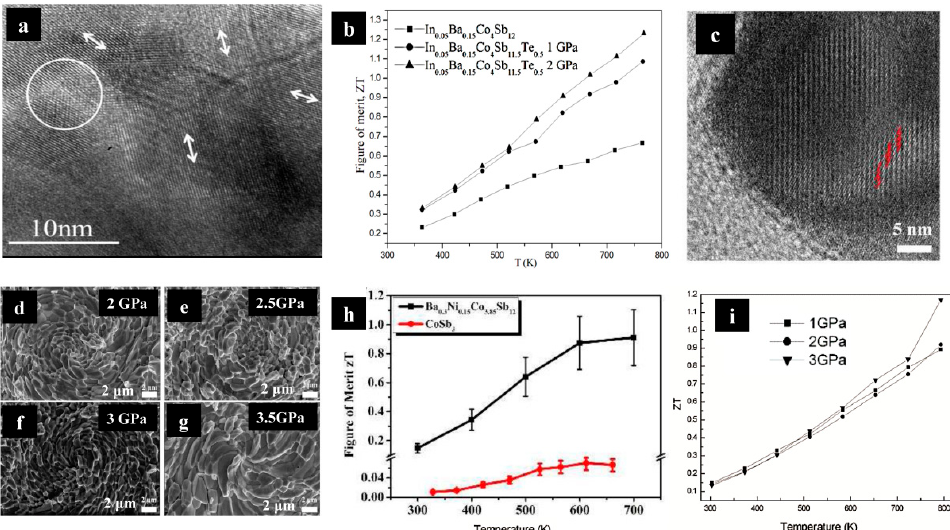
Figure 7. ( a ) HRTEM image of In 0.05 Ba 0.15 Co 4 Sb 11.5 Te 0.5 material; ( b ) temperature dependence of ZT values for In 0.05 Ba 0.15 Co 4 Sb 12 and In 0.05 Ba 0.15 Co 4 Sb 11.5 Te 0.5 samples [55]; ( c ) HRTEM image of Ba 0.3 Ni 0.15 Co 3.85 Sb 12 material; ( d – g ) FESEM images of Ba 0.3 Ni 0.15 Co 3.85 Sb 12 prepared under different pressures; ( h ) temperature dependence of ZT values for CoSb 3 and Ba 0.3 Ni 0.15 Co 3.85 Sb 12 samples at 3 GPa [56]; ( i ) Temperature dependence of ZT values of CoSb 2.75 Te 0.2 Sn 0.05 sample prepared under different pressure conditions